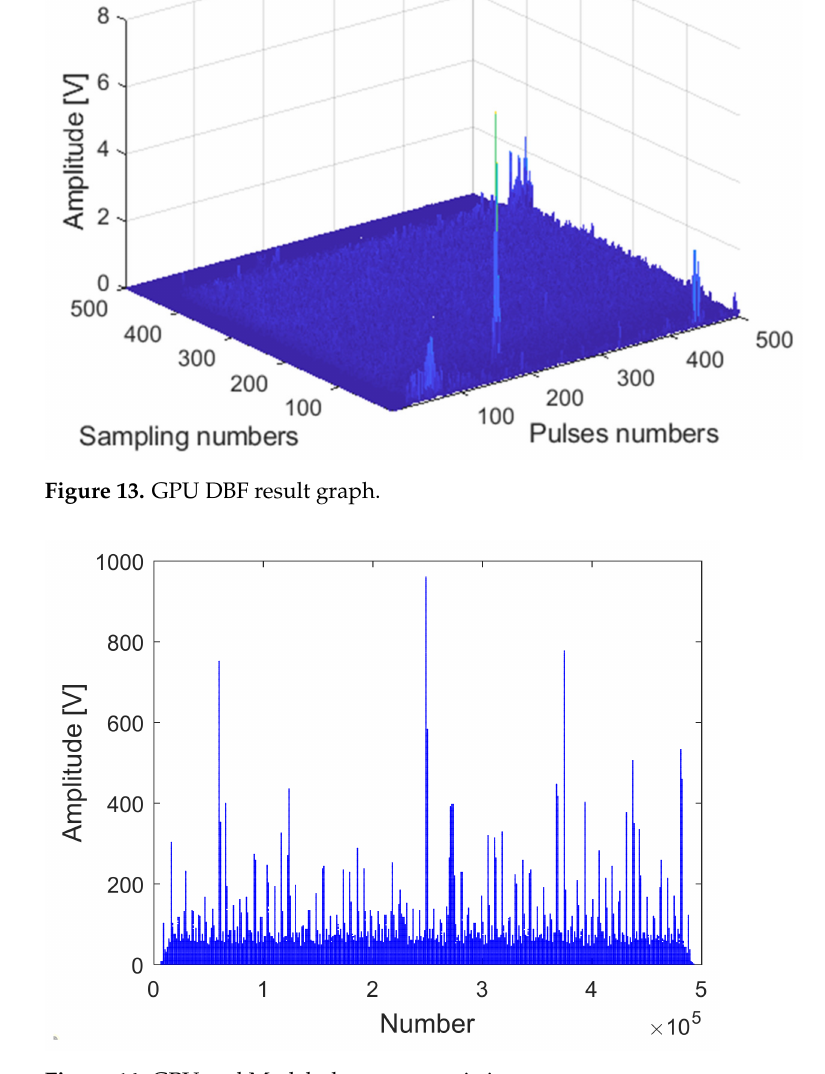
Figure 14. GPU and Matlab data error